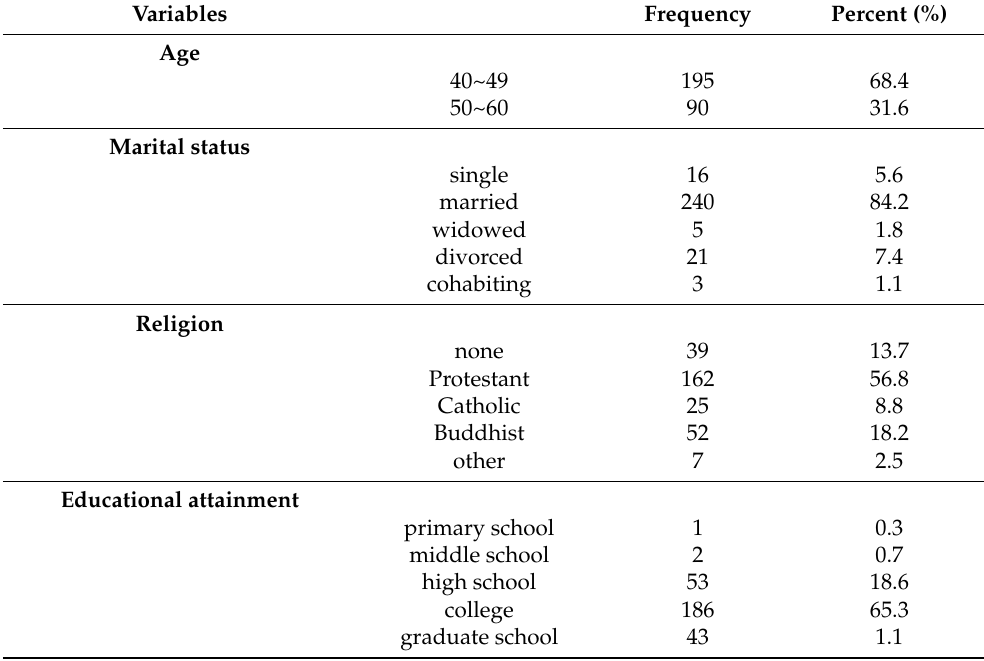
Table 1. Characteristics of participants ( N =